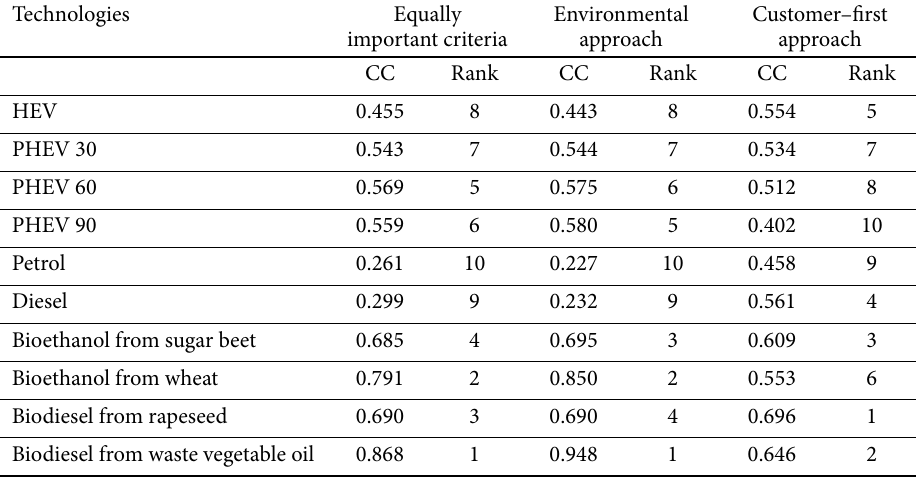
Table 8. Closeness coefficients (CC) and ranks for energy technologies